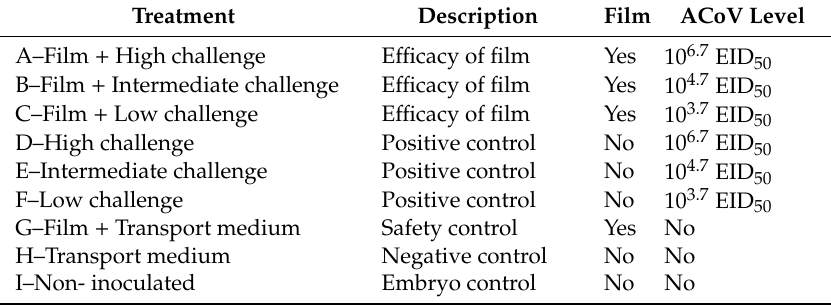
Table 1. Experimental design used for evaluation of the film’s antiviral activity for hands formulation and inanimate surface